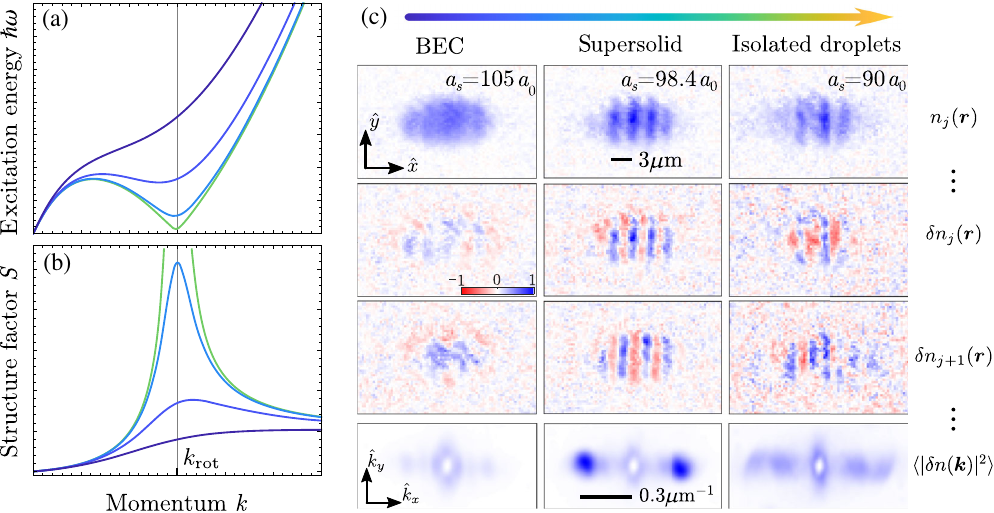
FIG. 1. (a),(b) Schematic of the dispersion relation ℏ ω ð k Þ and associated static structure factor S ð k Þ of an elongated and strongly dipolar BEC [22]. A decrease in scattering length a s causes a roton minimum to emerge in the excitation spectrum, associated with a characteristic peak in the static structure factor. The roton momentum k is indicated where the roton minimum drops near zero. (c) For rot a given scattering length a s , we observe a large number of in situ densities n j ð r Þ and calculate their mean h n ð r Þi and the density fluctuations δ n j ð r Þ ¼ n j ð r Þ − h n ð r Þi as the deviation of the in situ images from their mean. Investigating the mean power spectrum of the fluctuations hj δ n ð k Þj 2 i for different scattering lengths across the transition allows us to directly observe the static structure factor as the system passes from BEC to supersolid to isolated droplet states. The colored arrow on top indicates the direction toward lower scattering lengths, passing from BEC to supersolid to isolated droplet regimes. The color map used for the images shows the normalized amplitude of densities, density fluctuations, and mean power spectra, respectively, with the color bar referring to each row